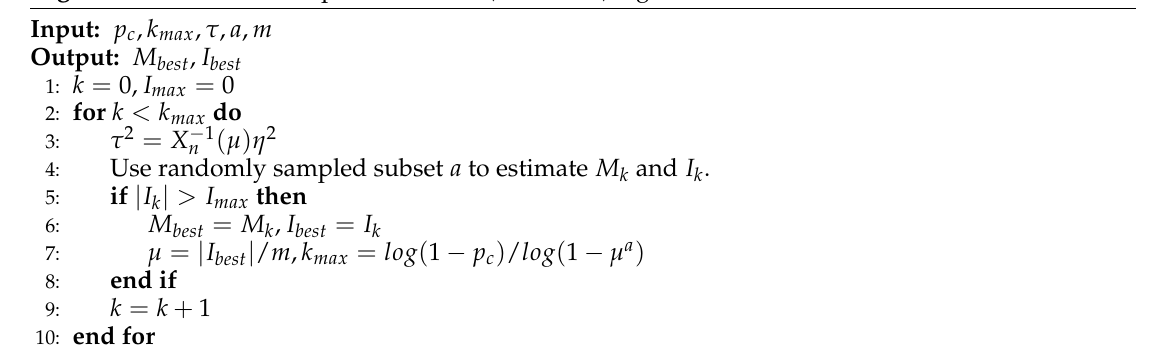
Algorithm 3 Random Sample Consensus (RANSAC) algorithm